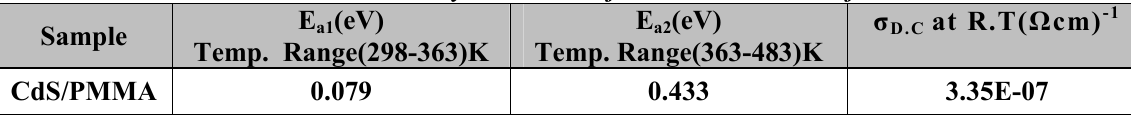
Fig. 9: Ln( σ ) versus 1000/T for CdS/PMMA thin film. Table 2: D.C. Conductivity Parameters for CdS/PMMA thin